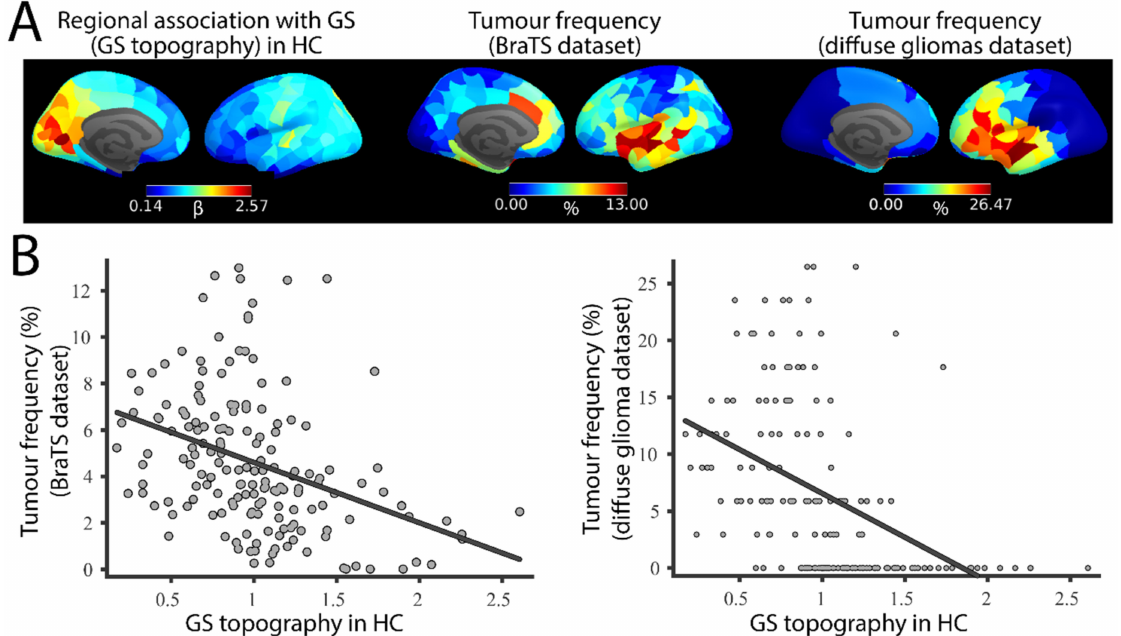
Figure 2. Spatial correlation between GS topography and tumour frequency. ( A ). GS topography is associated with tumour occurrence. ( B ). Associations between GS and regional signals (GS topography) derived from HCs (left) and tumour occurrence in the BRATS (middle) and diffuse glioma (right)